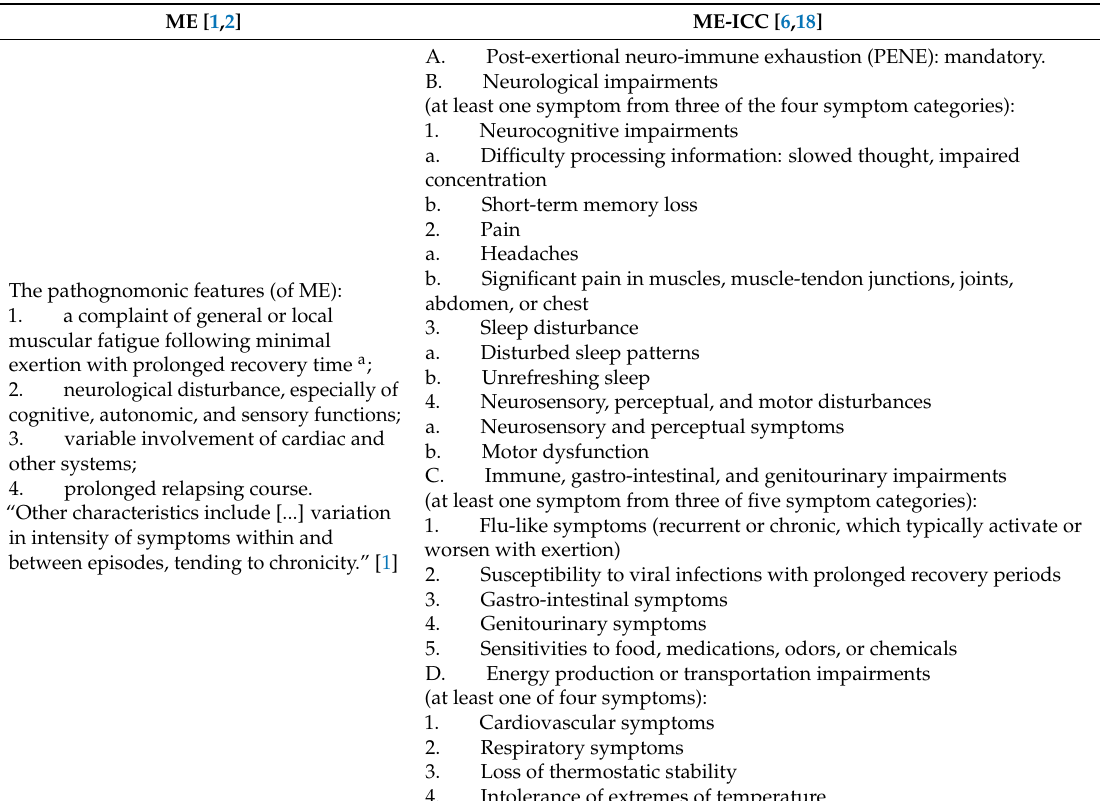
Table 1. The case criteria of myalgic encephalomyelitis (ME) [1,2] and the International Consensus Criteria for ME (ME-ICC)